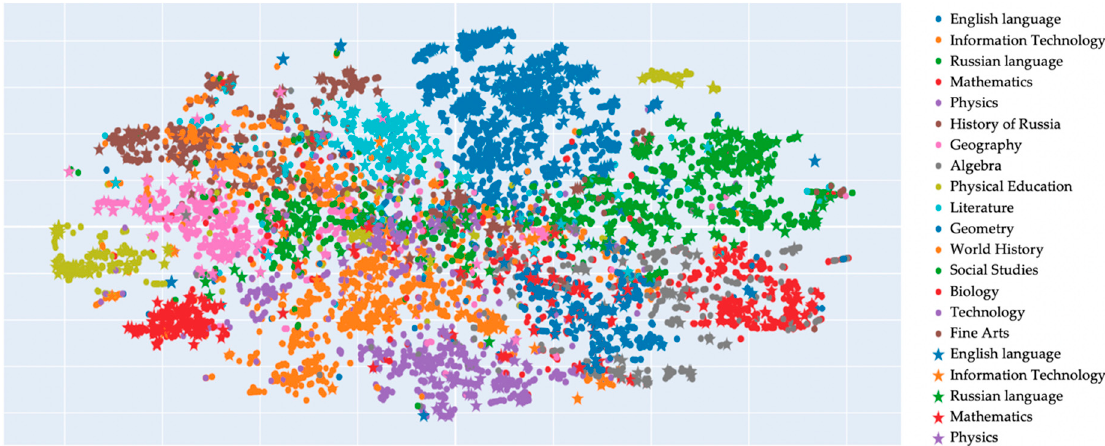
Figure 2. Visualization of lesson scripts in the MES by subject topic proximity. Basic general education.